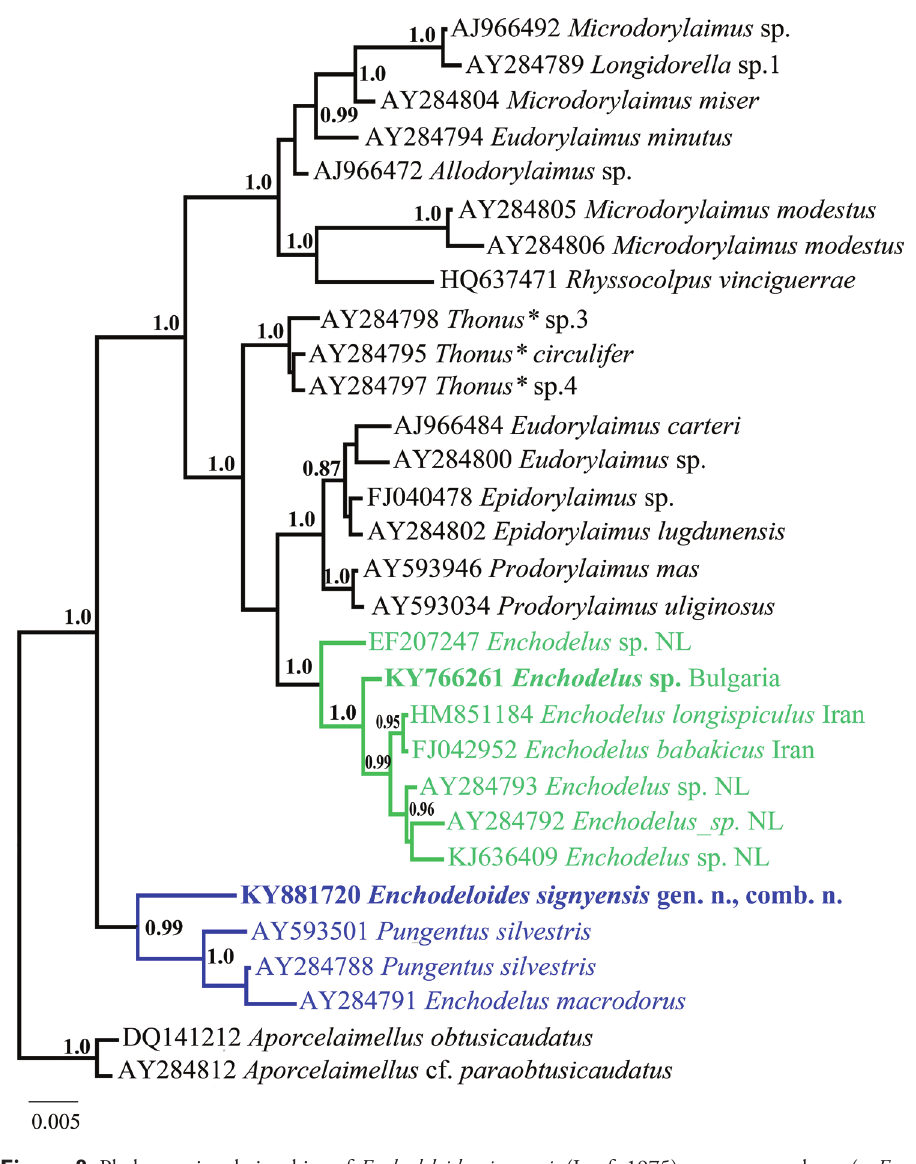
Figure 8. Phylogenetic relationships of Enchodeloides signyensis (Loof, 1975), gen. n., comb. n. (= En- chodelus signyensis Loof, 1975) based on 18S rDNA inferred from a Bayesian analysis (GTR+G model) and two Aporcelaimellus species used as an outgroup. * Thonus is currently considered a synonym of Cras- solabium (Peña-Santiago and Ciobanu,